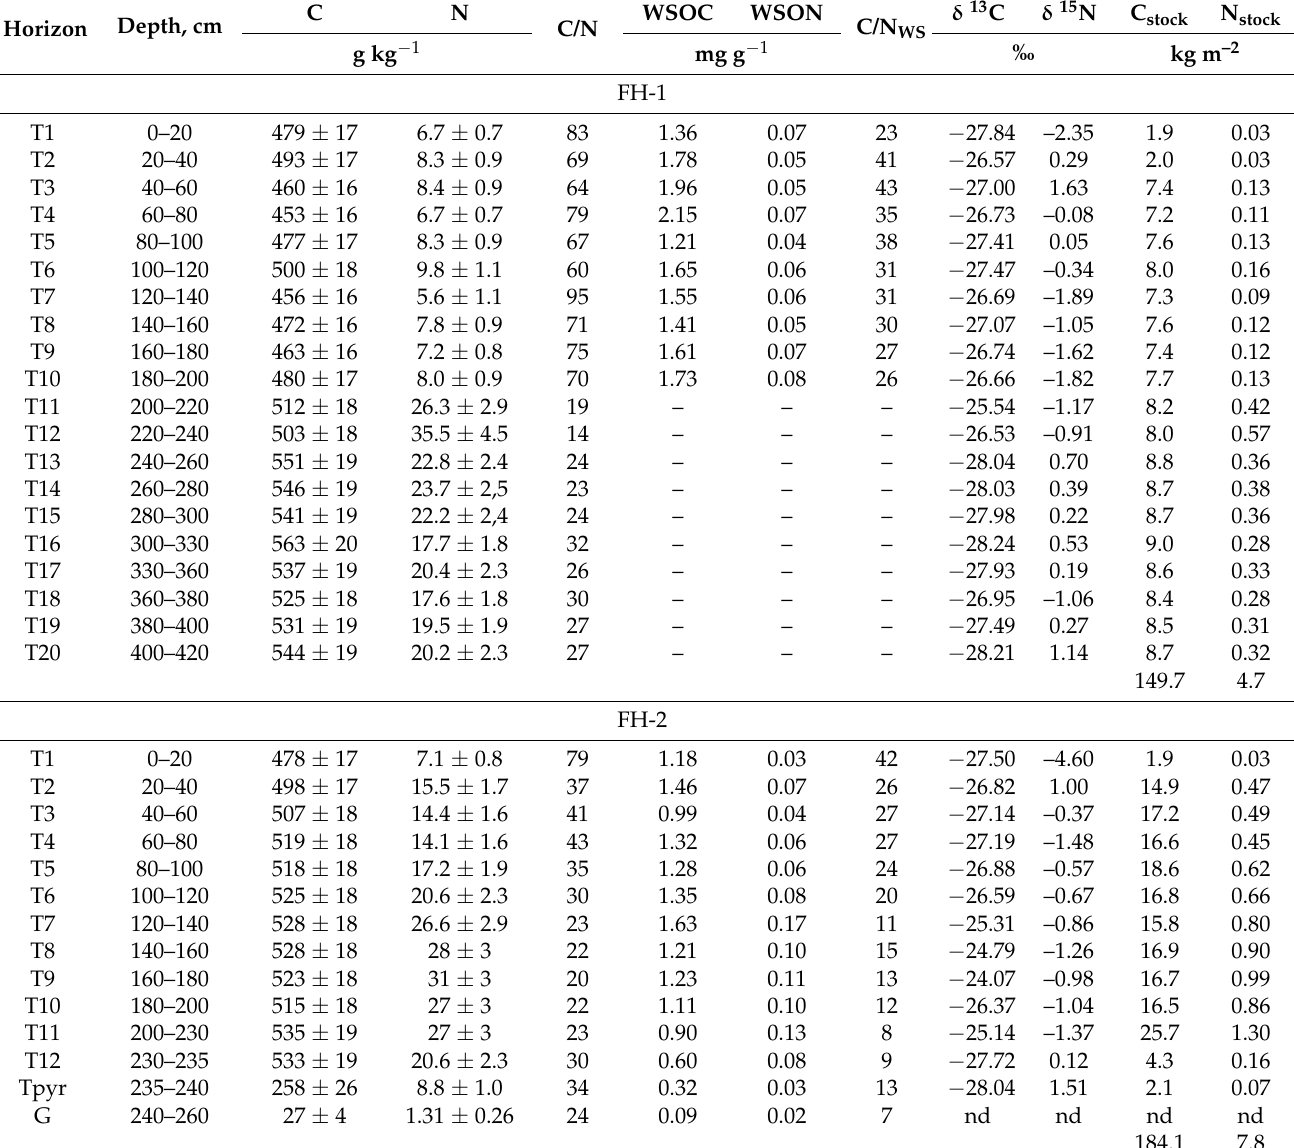
Table 2. Carbon and nitrogen content in studied